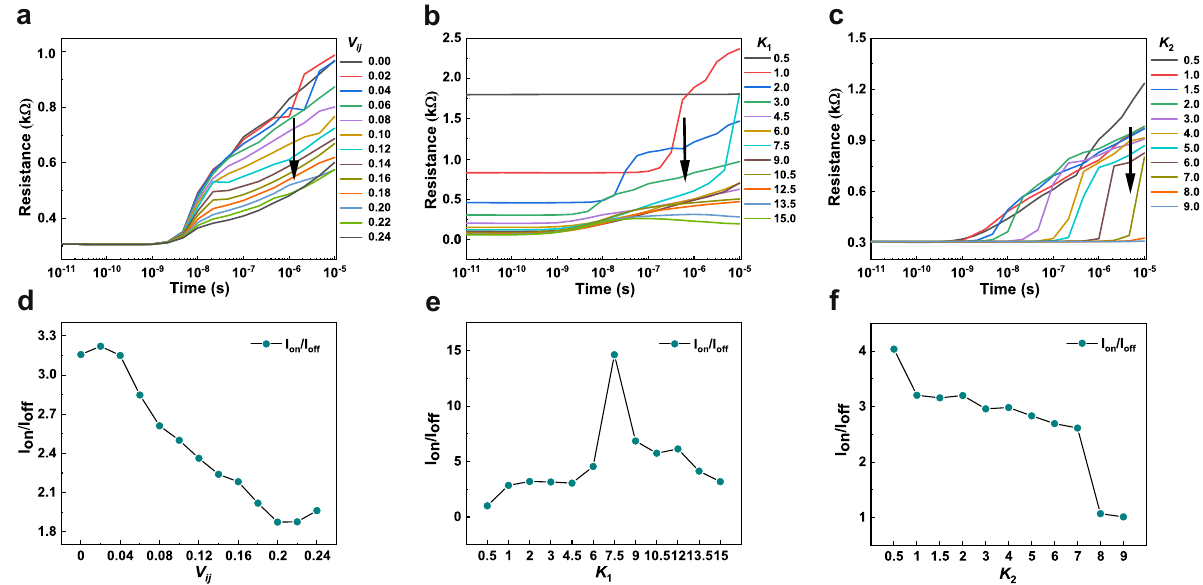
Fig. 3 Effects of material parameters on the device performance. a – c Temporal evolutions of overall resistance with different Vegard strain coef fi cient V ij , electrical conductivity (by K 1 ), and thermal conductivity (by K 2 ), d – f dependence of current on/off ratio I on / I off on V ij , K 1 and K 2